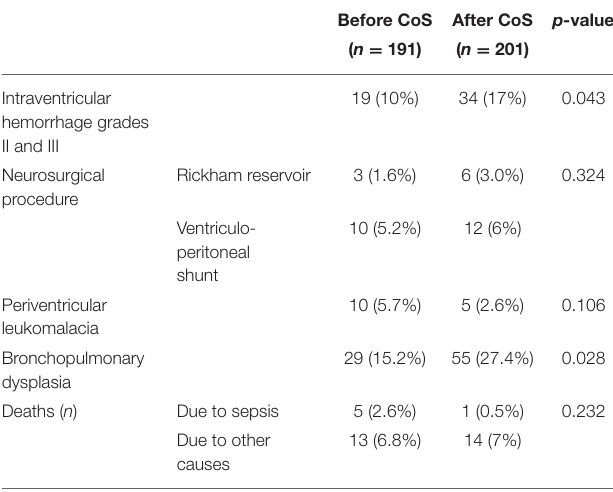
TABLE 2 | Comparison of morbidity and mortality between the two cohorts before and after the introduction of colonization screening (CoS). Before CoS After CoS p- value